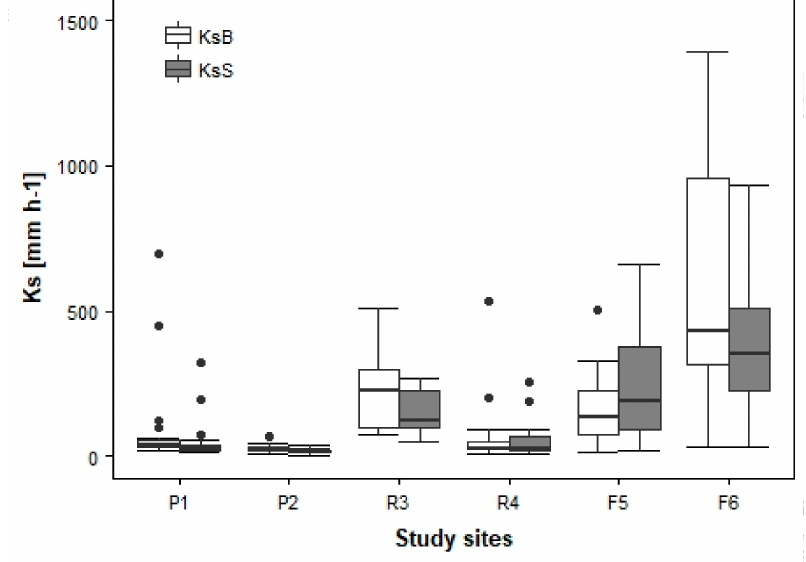
Figure 3. Comparison between K s estimated with BEST-steady, K sB , and the SSBI method, K sS . Study sites are abbreviated with P1 and P2 for pasture, R3 and R4 for restored forest, and F5 and F6 for remnant